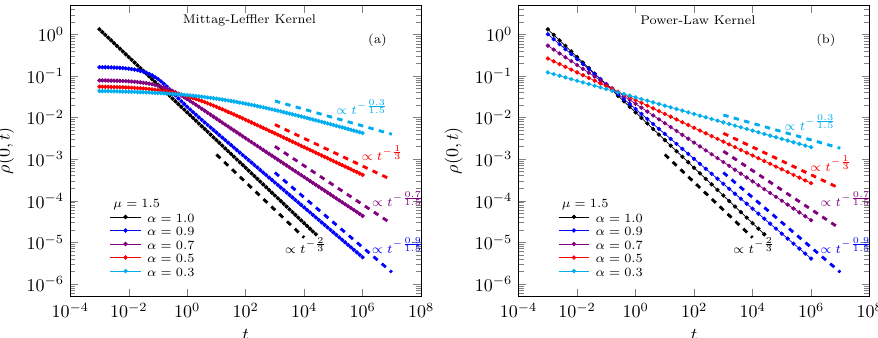
Figure 3. These figures show a series of curves (Sokolov analysis [68]) that represent the differences among Mittag–Leffler kernel ( a ) and power-law kernel ( b ) in Lévy process. The Mittag–Leffler cases are represented by Equation (33) and power-law cases are represented by Equation (4) to x = 0. In both figures, we consider the following values: µ = 1.5 (Lévy process),